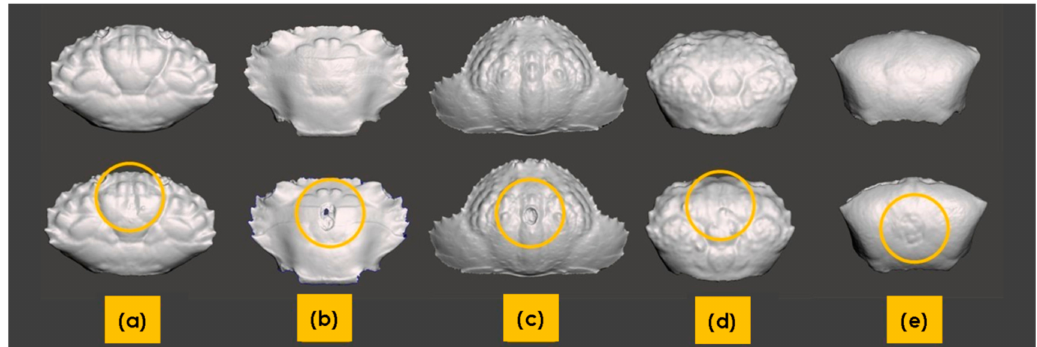
Figure 9. 3D scan images of crab carapaces (dorsal view) before ( top ) and after ( bottom ) impact. The regions of damage are encircled in the bottom images: ( a ) L. sanguineu ; ( b ) Thalamita sp. ( T. danae ); ( c ) C. hepatica ; ( d ) P. vespertilio ; ( e ) U. tetragonon